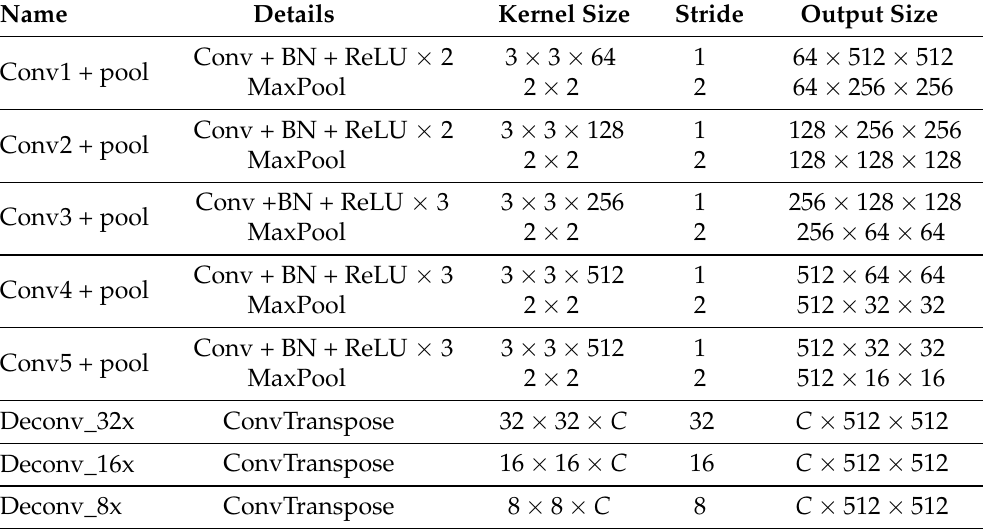
Table 3. Detailed structure of the network. Backbone: VGG16, Input size: 512 × 512, C : the number of object